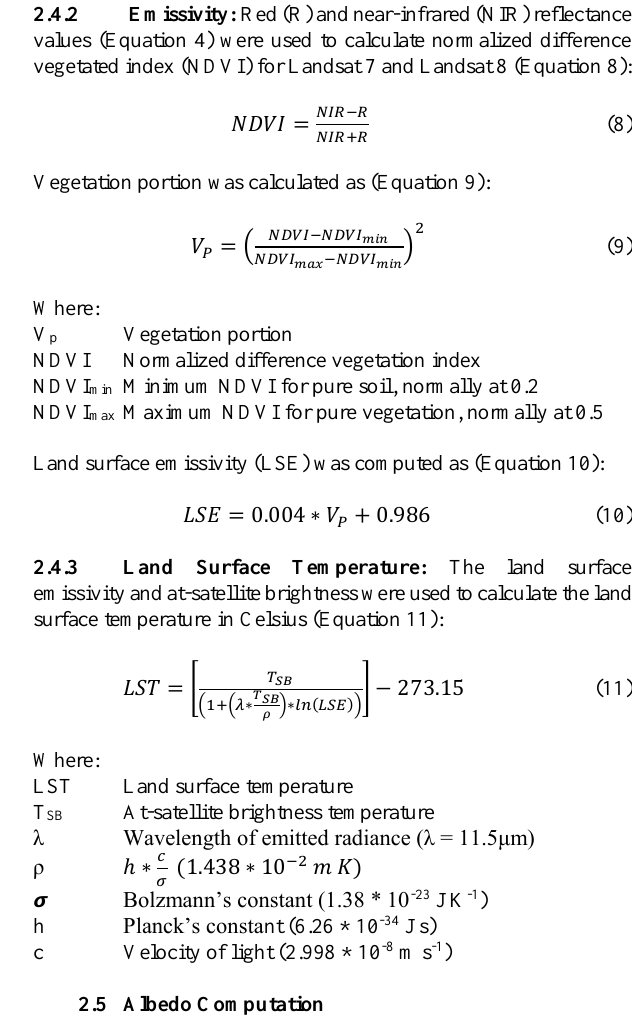
Table 3: Percentage change in land cover from 1986 to